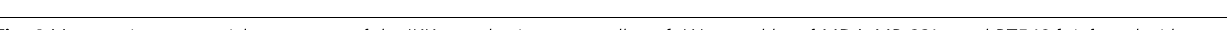
Fig. 4 Morgana is an essential component of the IKK complex in cancer cells. a , b Western blot of MDA-MB-231 a and BT549 b infected with an empty vector (EMPTY) or two Morgana shRNAs (shMORG1, shMORG2). c , d Immunoblot of MCF10A c and MCF7 d infected with an empty vector (EMPTY)